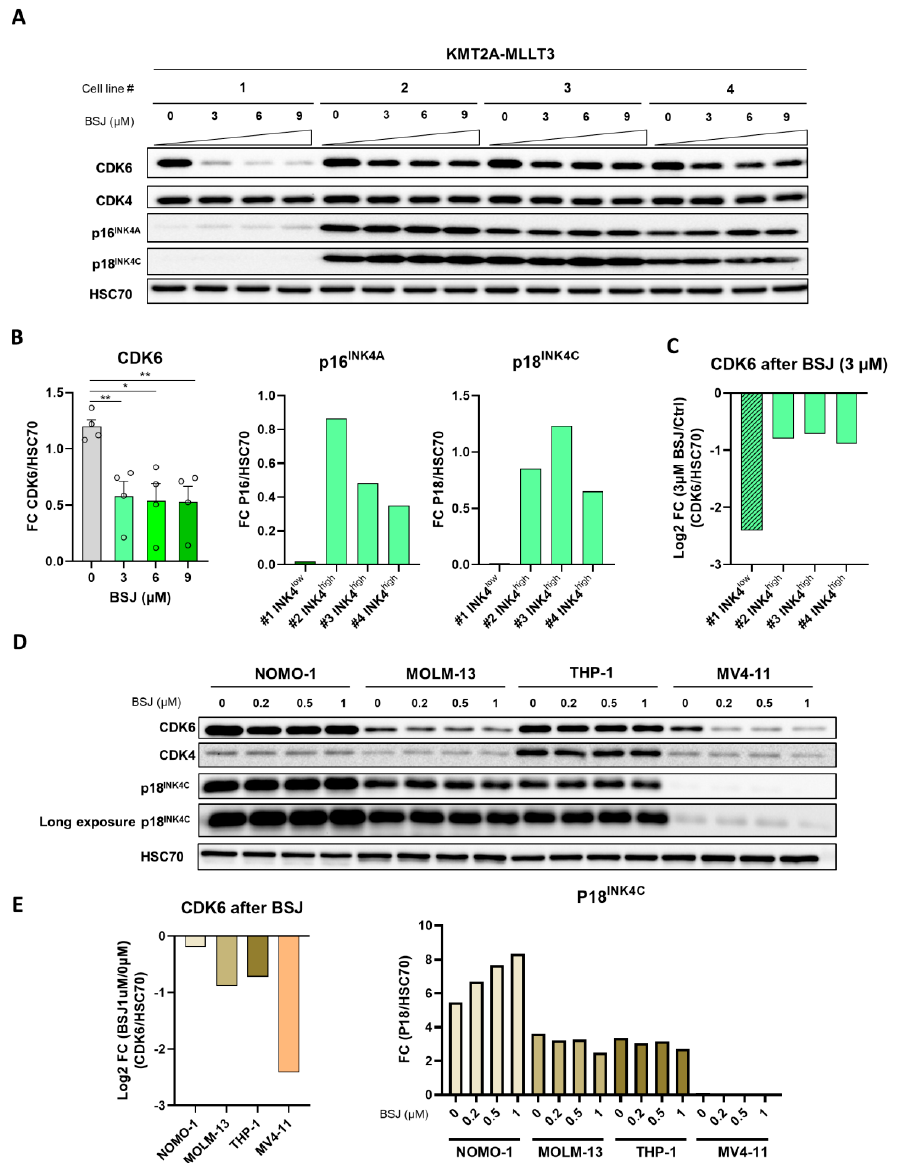
Figure 4. BSJ efficacy predicted by INK4 levels. ( A ) The immunoblot for CDK6, CDK4, p16 INK4A ,